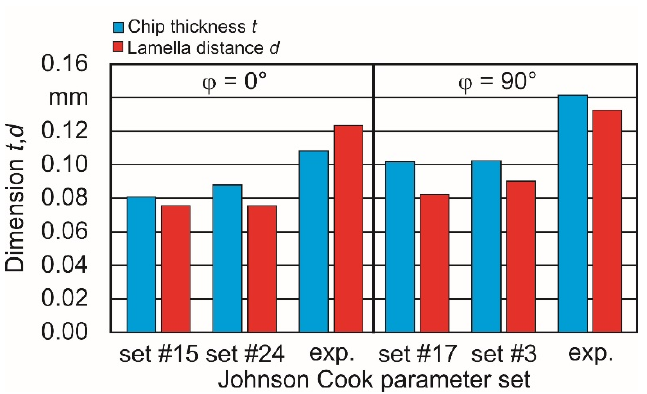
Figure 10. Chip shape criteria t and d depending on model and experiment-based results.